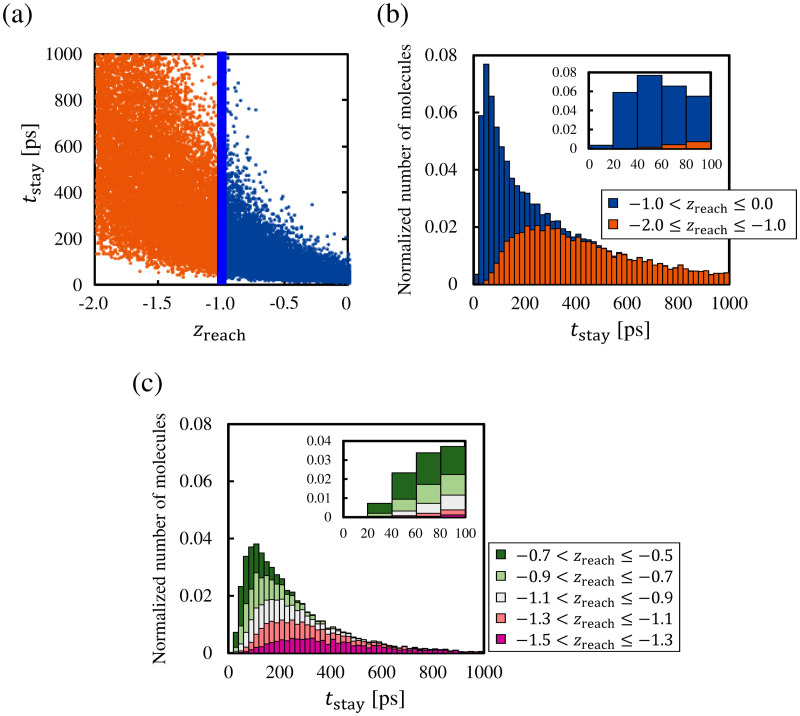
(a) Data points in −2.0 ≤ zreach ≤ 0.0 and 0 ps ≤ tstay ≤ 1000 ps. (b) Distribution of tstay of molecules with −2.0 ≤ zreach ≤ 0.0. (c) Distribution of tstay of molecules with −1.5 < zreach ≤ −0.5. Bar graphs with the time interval 20 ps are composed of the normalized number of molecules in each range of zreach.